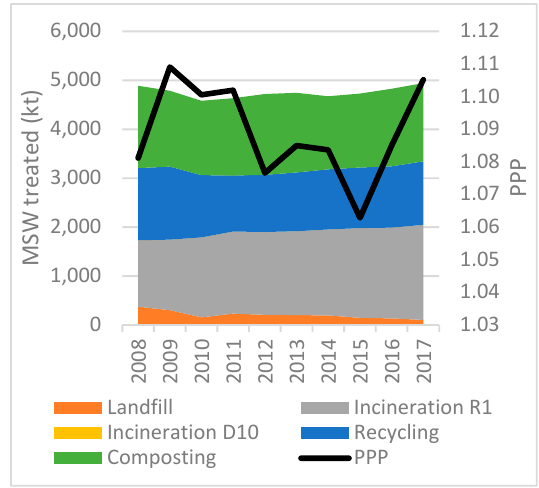
Figure 40. Waste treatment method and PPP in Austria 2008–2017 (EUROSTAT 2019b, 2019c).